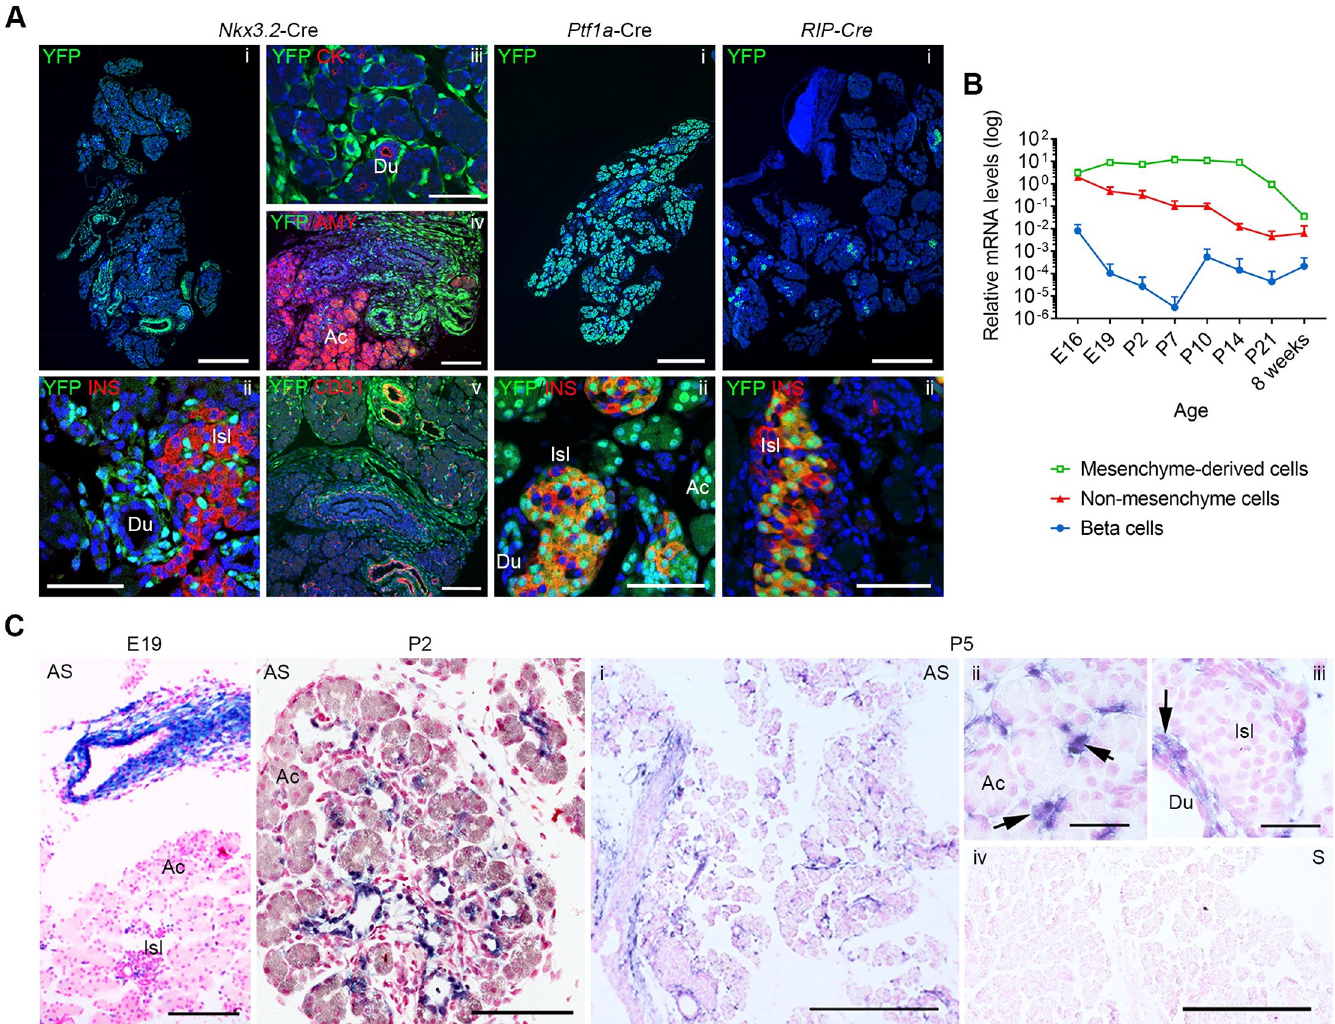
Fig 1. Developmental profiling of cell type specific Igf2 mRNA expression in mouse pancreas. (A) Assessment of Cre recombinase specificity using the Rosa26YFP - stop fl/fl reporter mouse line at postnatal day 2. Cells with a functional Cre recombinase express YFP protein (green). Nkx3 . 2 -Cre is active in mesenchyme-derived cells (pericytes, smooth muscle cells, stromal cells surrounding pancreatic ducts and acini, fibroblasts and myofibroblasts), Ptf1a -Cre in pancreatic epithelium (acinar cells, pancreatic islets and ducts) and RIP -Cre in pancreatic beta-cells. Sections were co-stained with insulin (INS) marker of pancreatic beta-cells; cholecystokinin (CK), marker of epithelial cells lining pancreatic ducts; amylase (AMY) marker of acinar cells and CD31, marker of endothelial cells. Scale bars are as following: 500 μ m in panels i corresponding to each Cre-line; 50 μ m in panels ii corresponding to each Cre-line; 100 μ m (panel iii) and 200 μ m (panels iv and v) for Nkx3 . 2 -Cre. (B) Timeline of Igf2 mRNA expression measured by qRT-PCR in YFP+ or YFP–FACS isolated cells from offspring of Nkx3 . 2 -Cre or RIP -Cre females mated with Rosa26YFP -stop fl/fl males (E–embryonic day; P–postnatal day). Highest levels of Igf2 expression are observed in the mesenchyme fraction ( Nkx3 . 2 -CreYFP+ cells) throughout development. Expression data is normalized to Ppia and is shown as average + SD (n = 3–5 per time point and cell fraction). (C) Igf2 mRNA analysis by in situ hybridization at E19, P2 and P5 showing high levels of expression in mesenchymal cells (purple colour). AS–antisense probe; S–sense probe (negative control); Ac– acinar cells; Isl–pancreatic islet; Du–pancreatic duct; arrows point to cells expressing high levels of Igf2 mRNA. Scale bars are as follows: E19 (300 μ m); P2 (100 μ m); P5 (30 μ m for higher resolution panels ii and iii and 300 μ m for lower resolution panels i and iv).